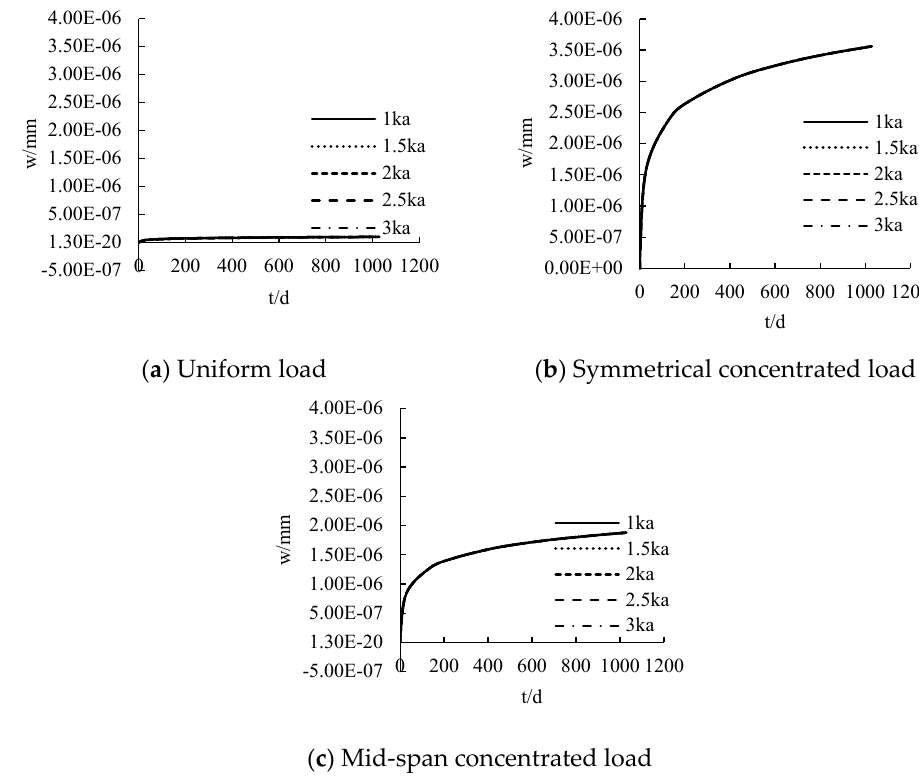
Figure 17. The influence of adhesive layer stiffness under creep on displacement.